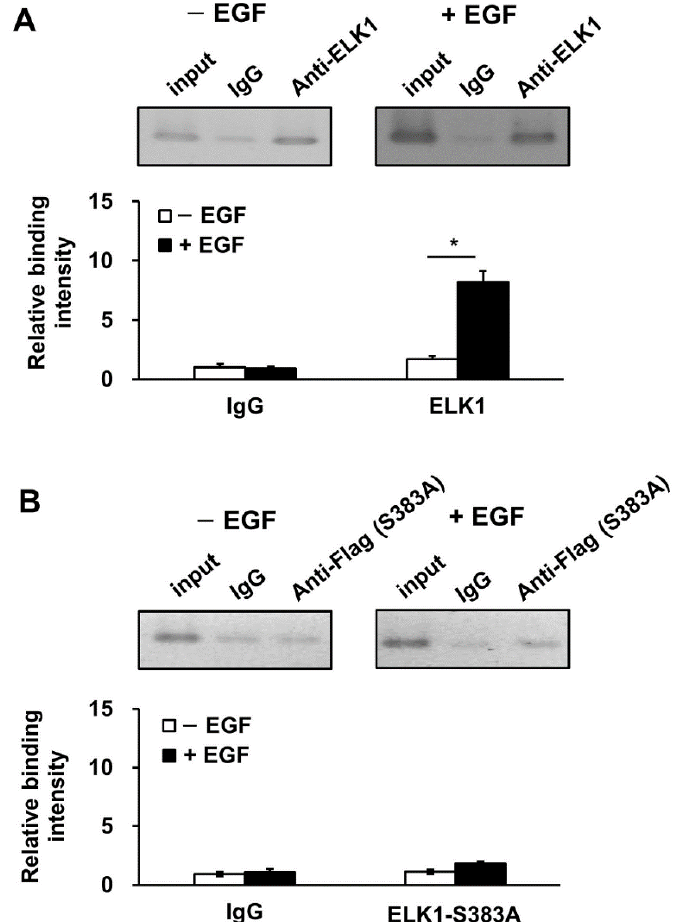
Figure 5. Effect of EGF treatment on DNA binding by ELK1 phosphorylation. HBECs were transfected with a luciferase reporter vector containing an enhancer region and ELK1 wild-type ( A ) or ELK1- S383A mutant-type ( B ), and SRF-expressing vectors and then treated with or without 100 ng/mL EGF for 60 min. ChIP-PCR was used to determine the binding ability of the ELK1-DNA complex using the anti-ELK1 antibody ( A ) or anti-Flag antibody ( B ) with PCR product electrophoresis images (upper panels). ChIP-PCR was performed using the non-immune IgG antibody as a control. The binding intensity by non-immune IgG and anti-ELK1 was calculated based on the band signals of ChIP-PCR using cells untreated and treated with EGF (lower graphs). Results are expressed as mean ± SE, n = 3, * p <